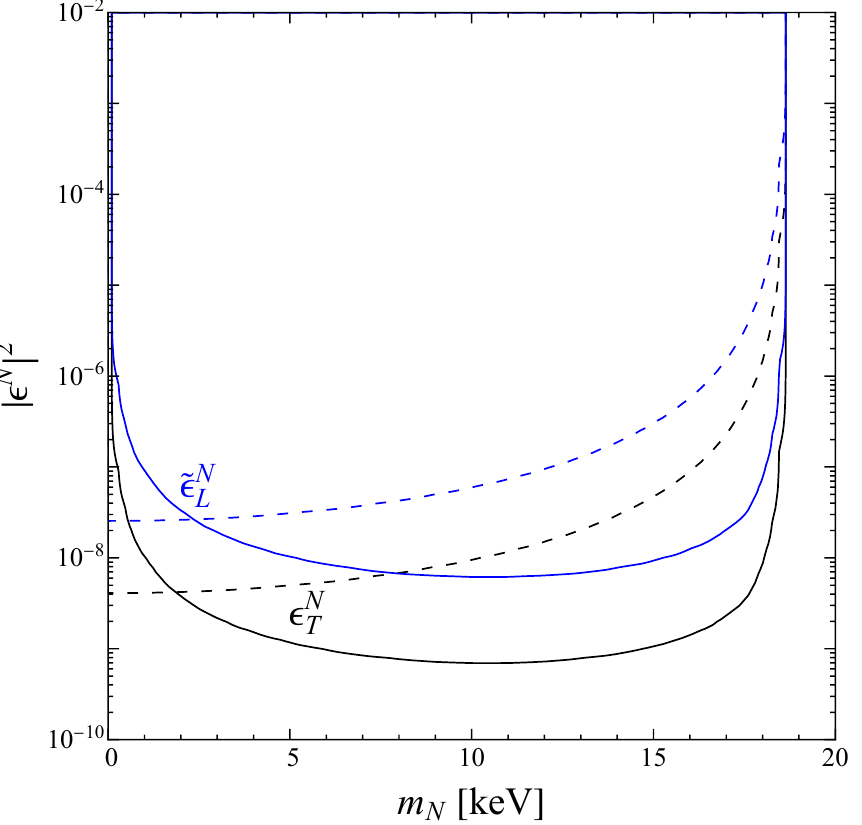
Figure 12 . Sensitivity at 95% CL to tensor and right-handed leptonic exotic currents as a function of the sterile neutrino mass using the energy (solid) and angular (dashed) distributions for currents parameterised by (cid:15) N (black) and (cid:15) N (blue). The active-sterile mixing is set to zero, | V eN | 2 = 0 e T L